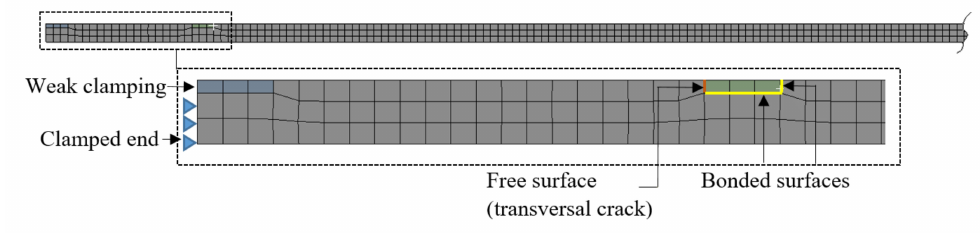
Figure 10. The finite element model of the damaged beam with weak